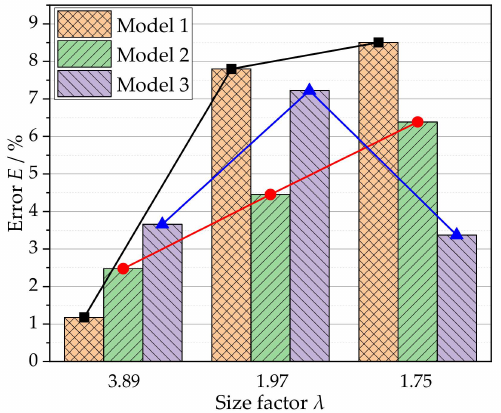
Figure 9. Errors between simulated and experimental yield loci under different size